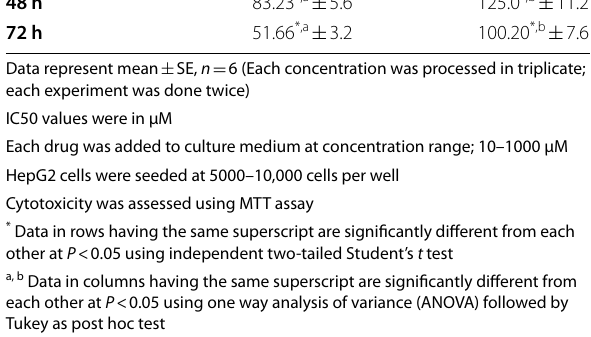
Table 1 Mean IC values for glufosfamide or ifosfamide in 50 HepG2 cells following different incubation time periods